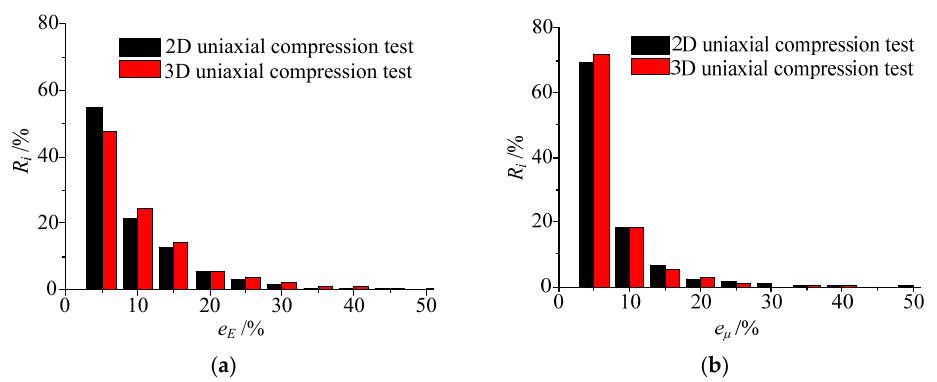
Figure 6. Statistics of the inversion error of ( a ) Young’s modulus field and ( b ) Poisson’s ratio field when Poisson’s ratio is heterogeneous.